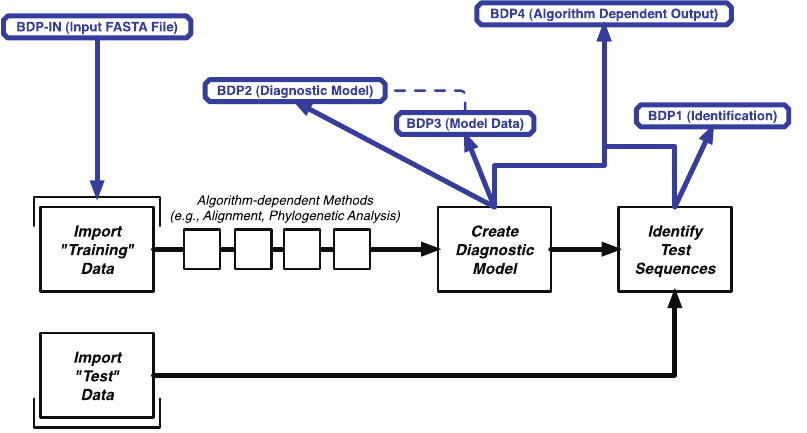
Figure 1. Overview of Common Data Analytic Process. Based on discussion with DAWG membership, the set of common steps (shown in black) that transcend across the range of data analytic applications was used to inform decisions for common file formats (shown in blue).